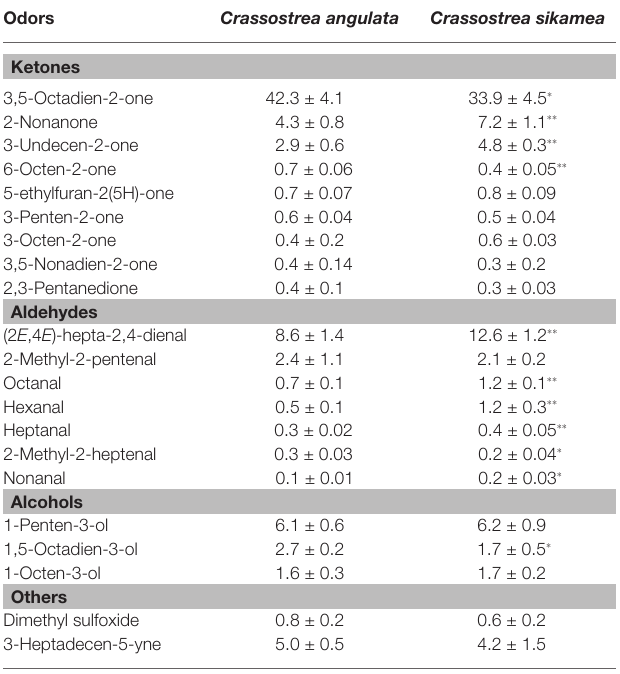
TABLE 3 | Volatile organic compounds content of Crassostrea sikamea and Crassostrea angulata in Xiangshan bay.